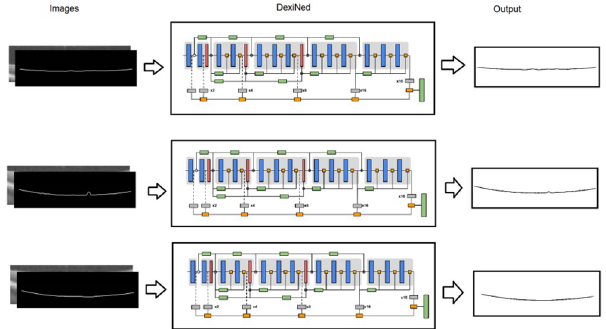
Fig 6. DexiNed network architecture. Font: Adapted from